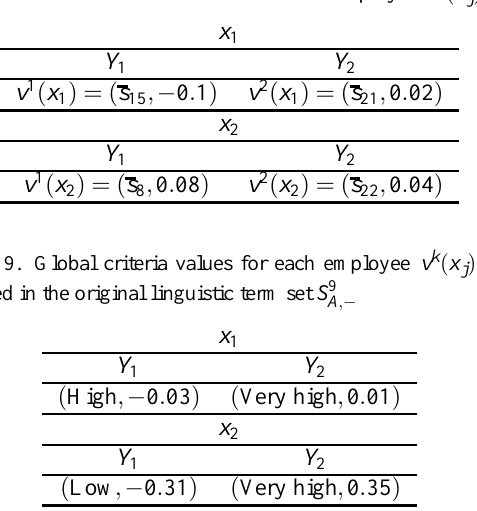
Table 8. Global criteria values for each employee v k ( x j )